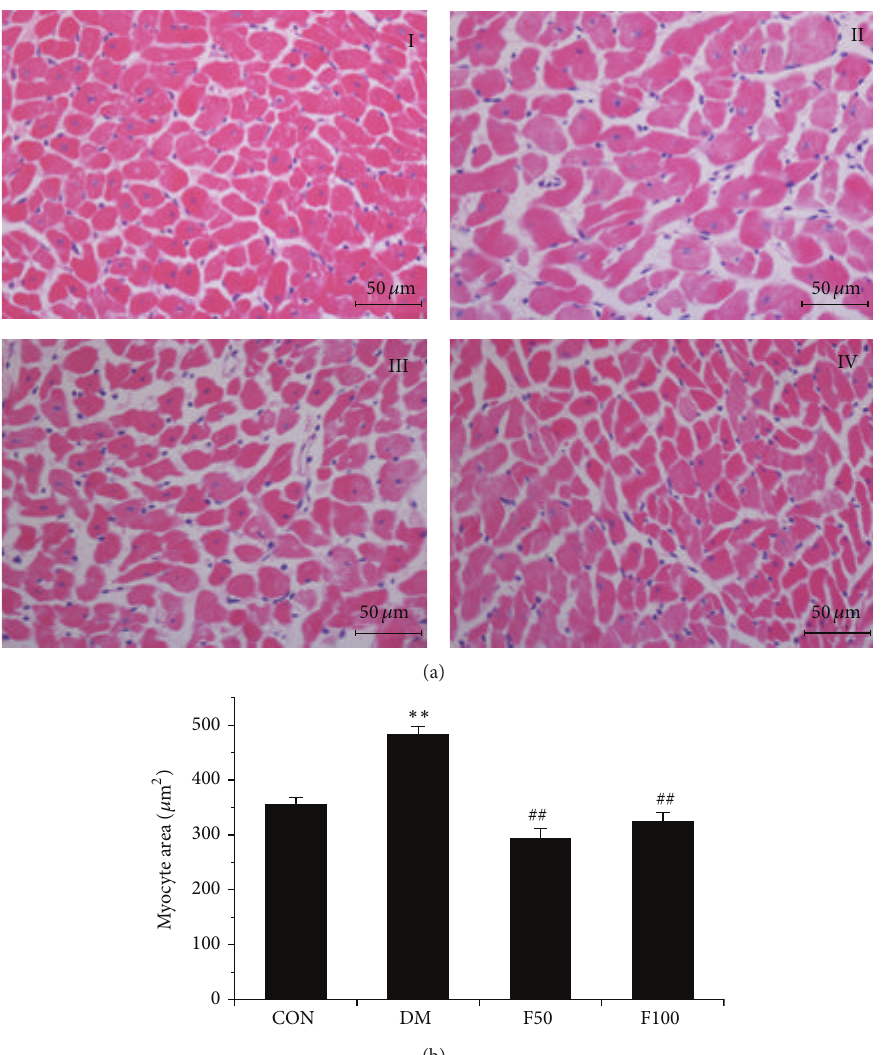
Figure 3: LMWF improved structural changes of myocardial tissue of diabetic GK rats. ((a), (b)) Representative micrographs of LV cross sections and myocyte cross-sectional area was measured in different groups and statistical analysis was performed ( 𝑁 = 3 , scale bar = 50 𝜇 m). I represents control group, II represents DM group, and III and IV represent diabetic rats administered with 50 and 100mg/kg/day LMWF, respectively. ∗∗ 𝑃 < 0.01 versus control group; ## 𝑃 < 0.01 versus DM